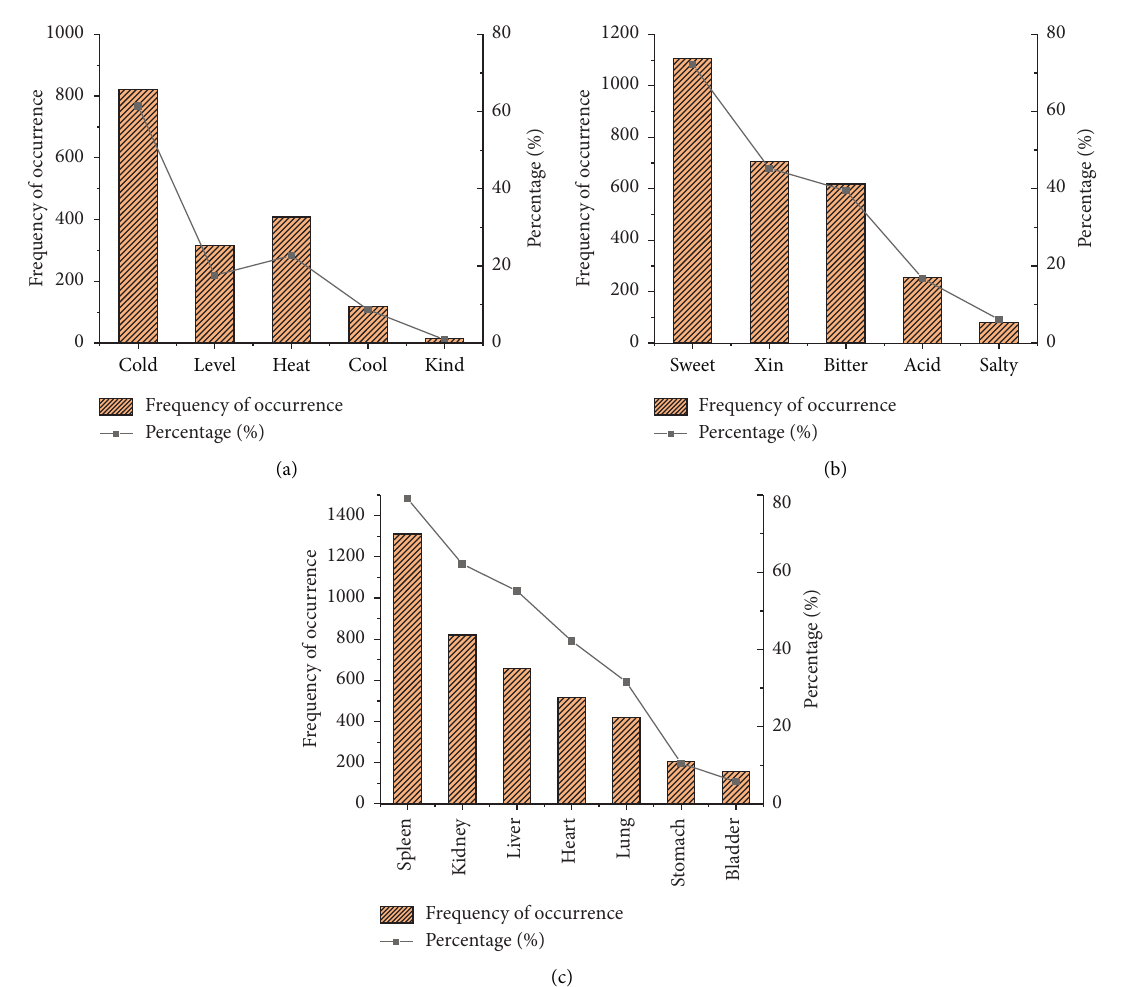
Figure 7: Results of the nature (a), flavor (b), and meridian (c) of the drugs in the prescription